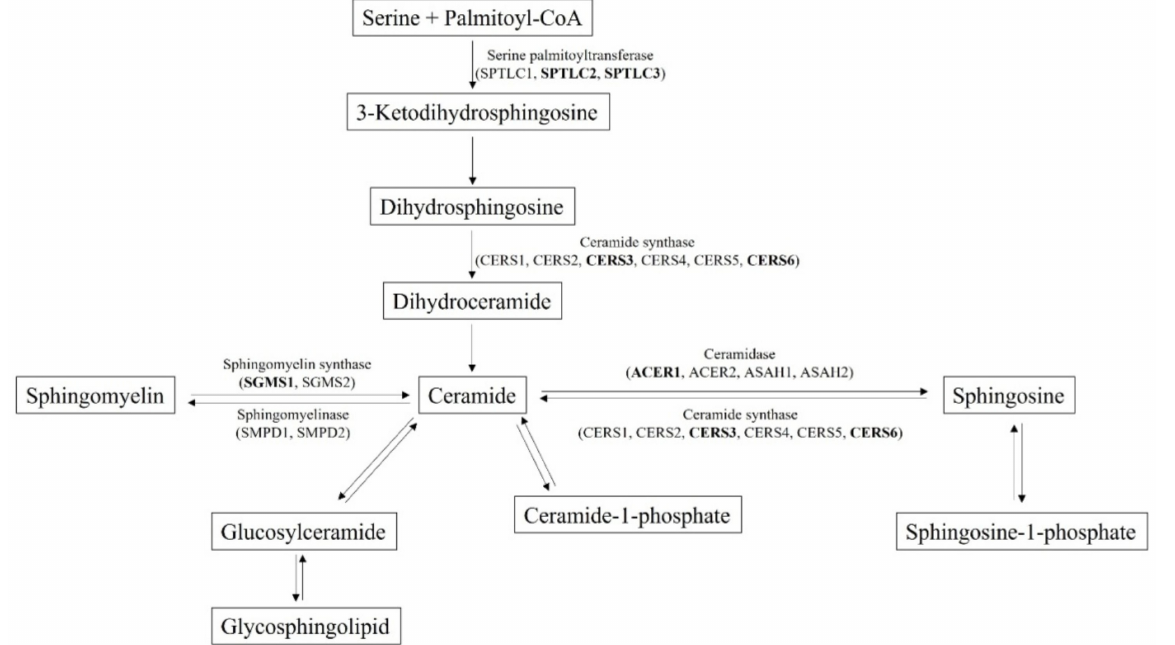
Figure 2. Genes associated with ceramide biosynthesis pathway. Loci in bold are those with variants identified in our